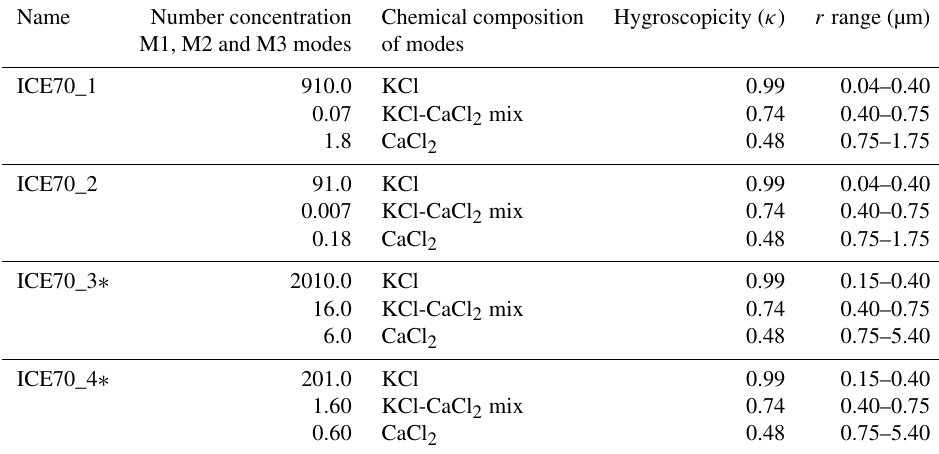
Table 3. Characteristics of the ICE70 aerosol particles. The unit of concentrations is cm − 3 . Cases without an asterisk use aerosol size distributions (ASDs) from the SPEC UAE project (Wehbe et al. 2021); cases marked with an asterisk use ASDs from Tessendort et al. (2021). The size ranges for M1, M2 and M3 are indicated in Fig. 2c using different line patterns. The hygroscopicity parameters and size ranges are related to modes M1, M2 and M3,